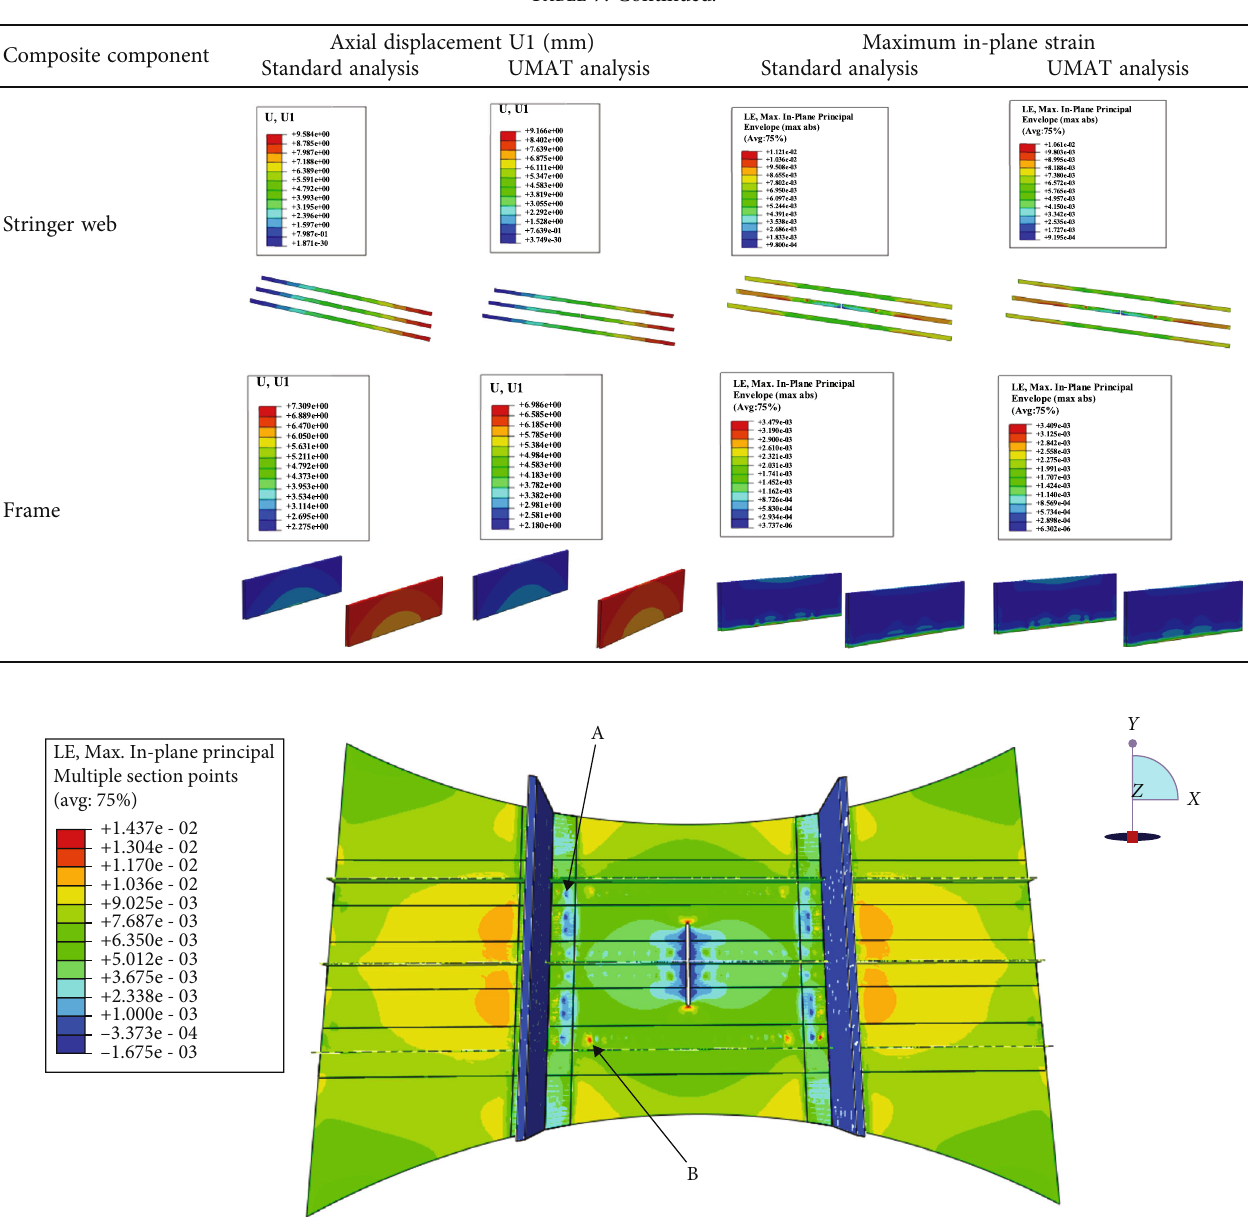
Figure 17: Standard analysis repaired panel maximum in-plane principal strain (the repair panel is